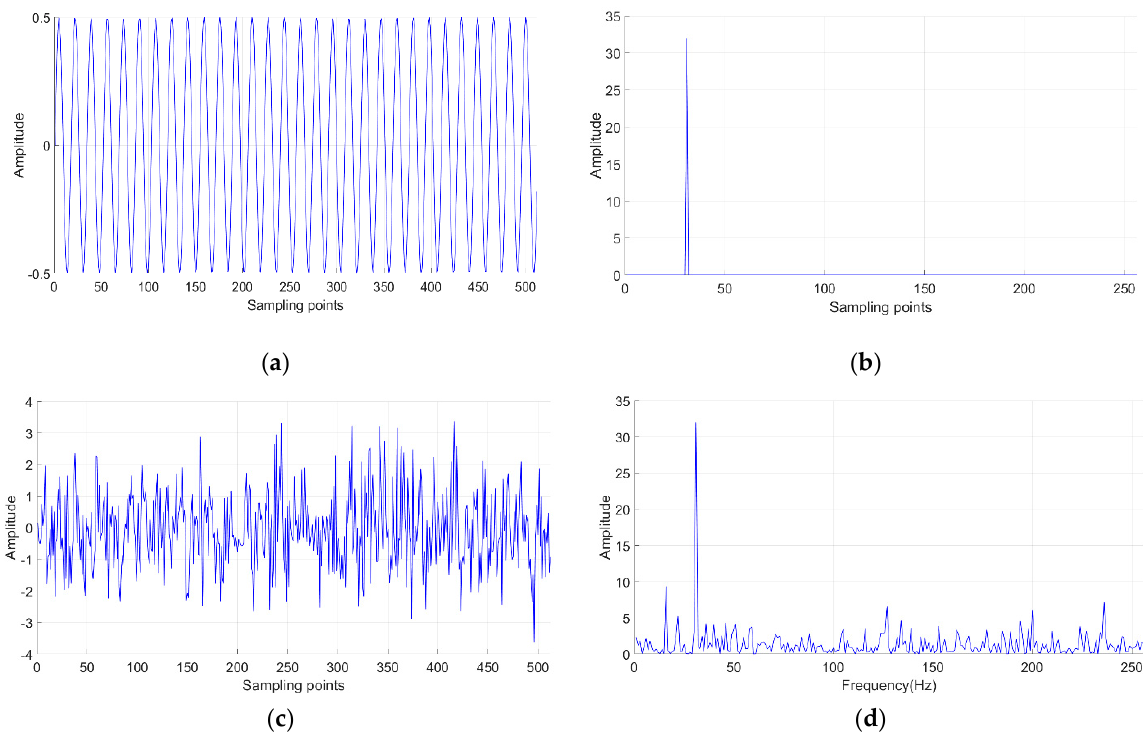
Figure 10. Cosine signal and its power spectrum under noise absence and presence. ( a ) Waveform in time domain without noise. ( b ) Power spectrum of ( a ). ( c ) Waveform in time domain with noise, where SNR is –10 dB. ( d ) Power spectrum of ( c ).